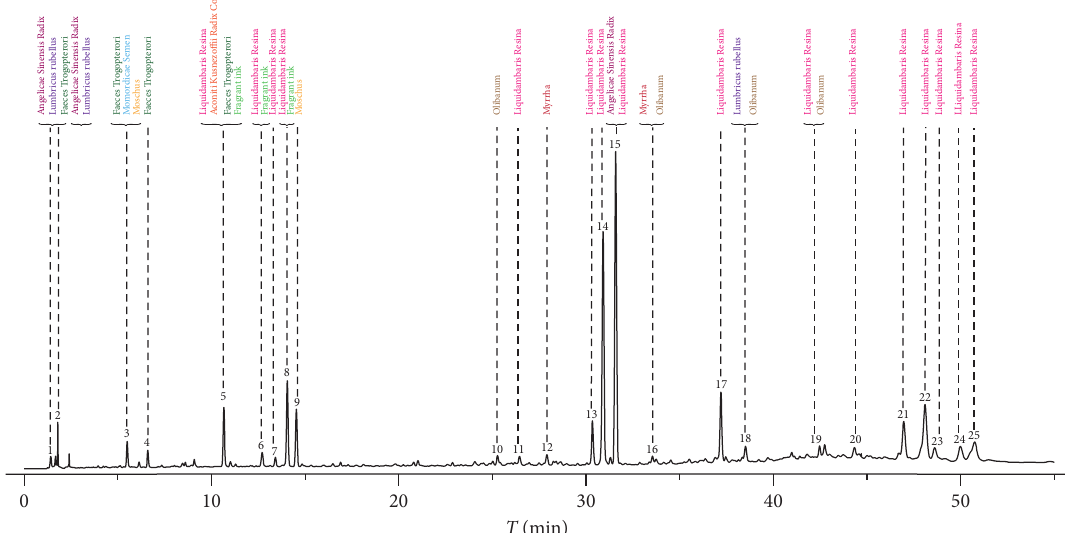
Figure 4: The origin of common peaks in the standard fingerprint chromatogram of XJC samples.